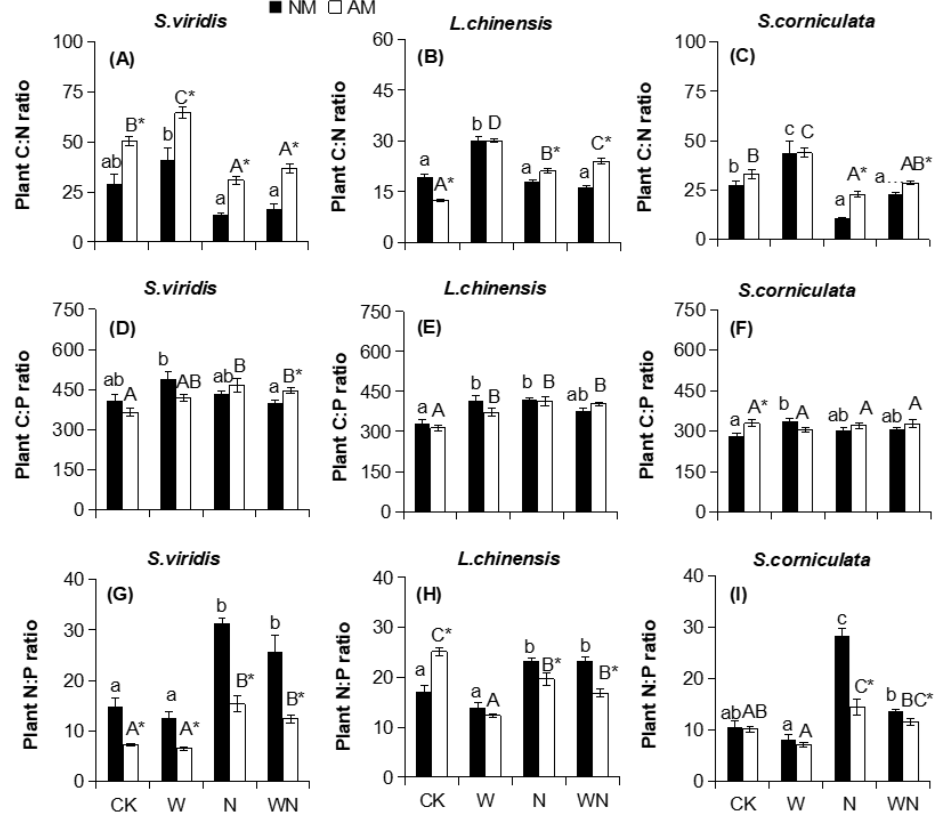
Figure 2. Effects of AMF on the C:N, C:P, and N:P ratios of S. viridis (A, D and G) , L. chinensis (B, E and H) and S. corniculata (C, F and I) under warming and N input. Different lowercase and capital letters above bars indicate significant differences ( p < 0.05) among different warming and N input treatments within the same AMF treatment. Asterisks indicate significant differences ( p < 0.05) between AMF treatments within the same warming and/or N input condition. CK, control; N, N input; W, warming; and WN, combination of warming and N input.